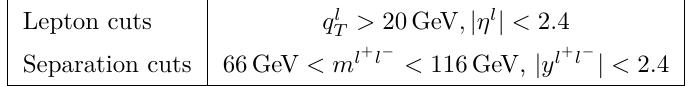
√ s = 8 TeV , see ref.